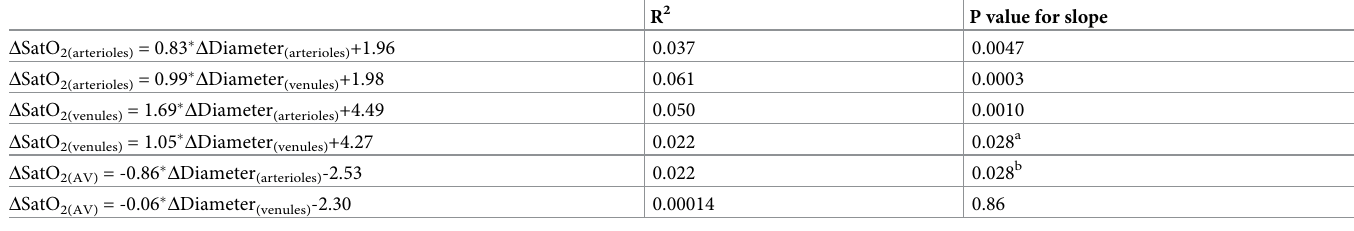
Table 3. Linear regression between the change in saturation ( Δ SatO 2 ) between visits and change in diameter ( Δ Diameter). R 2 P value for